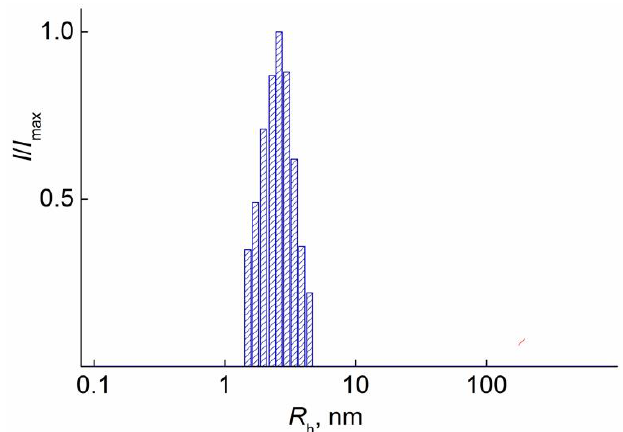
Figure 3. Hydrodynamic radii distribution for solution of pEPM at c = 0.0052 g · cm − 3 in acetonitrile. I max is the maximum intensity of scattered light for given solution concentration.